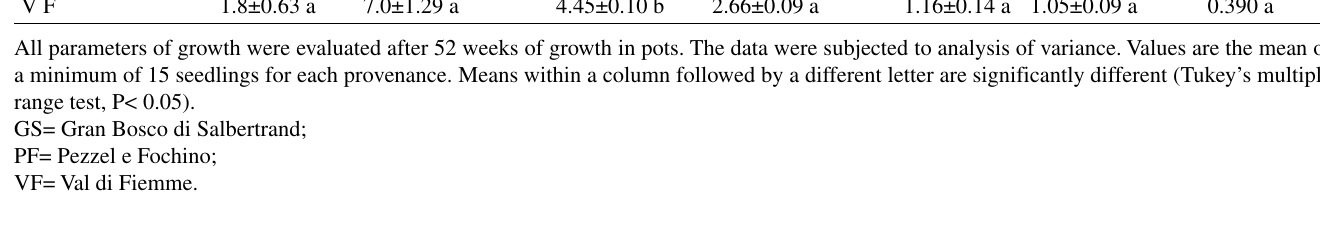
Table 5 - Induction of embryogenic cultures, proliferation, and somatic embryo maturation